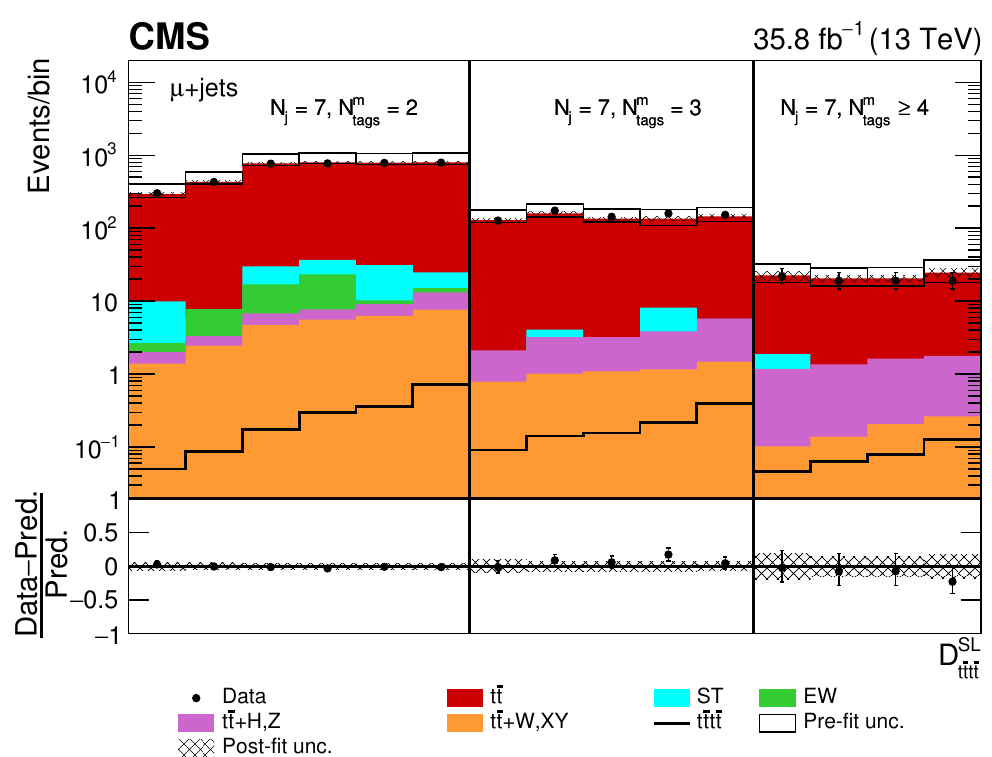
Figure 6 . Post-(cid:12)t D SL distribution in the single-muon channel for events satisfying baseline single- tttt lepton selection and N = 7, N m = 2, 3, (cid:21) 4. Non-uniform binning of the BDT discriminant was j tags chosen to achieve approximately uniform distribution of the tt background. Dots represent data. Vertical error bars show the statistical uncertainties in data. The post-(cid:12)t background predictions are shown as shaded histograms. Open boxes demonstrate the size of the pre-(cid:12)t uncertainty in the total background and are centered around the pre-(cid:12)t expectation value of the prediction. The hatched area shows the size of the post-(cid:12)t uncertainty in the background prediction. The signal histogram template is shown as a solid line. The lower panel shows the relative di(cid:11)erence of the observed number of events over the post-(cid:12)t background